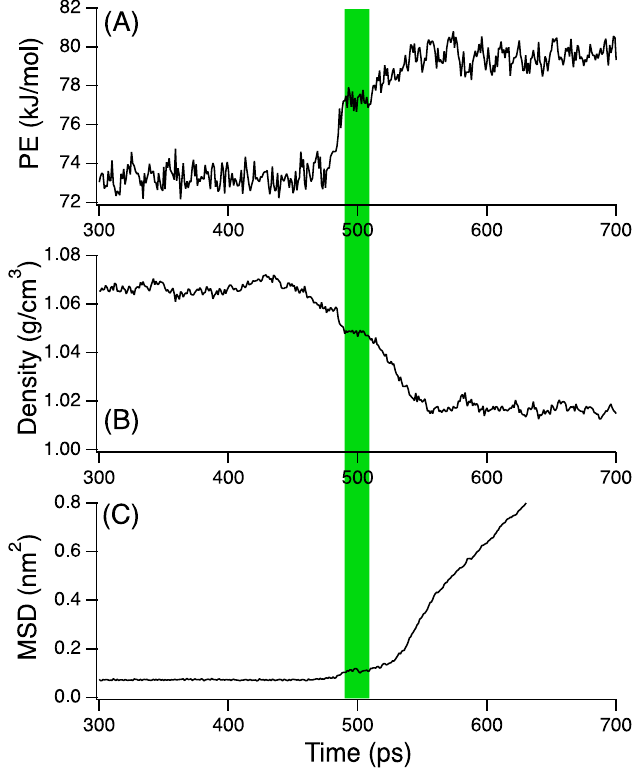
Figure 2. Time dependence of ( A ) PE, ( B ) density, and ( C ) MSD for the melting of benzene phase I at 584 K. The time range when the metastable phase is formed is shaded in green.